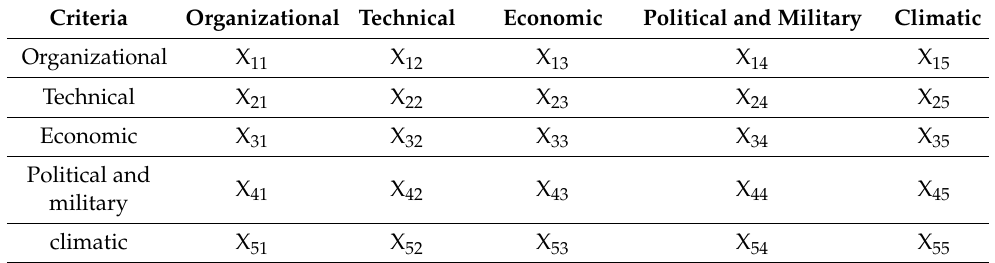
Table 4. Pairwise comparison of the main criteria. Criteria Organizational